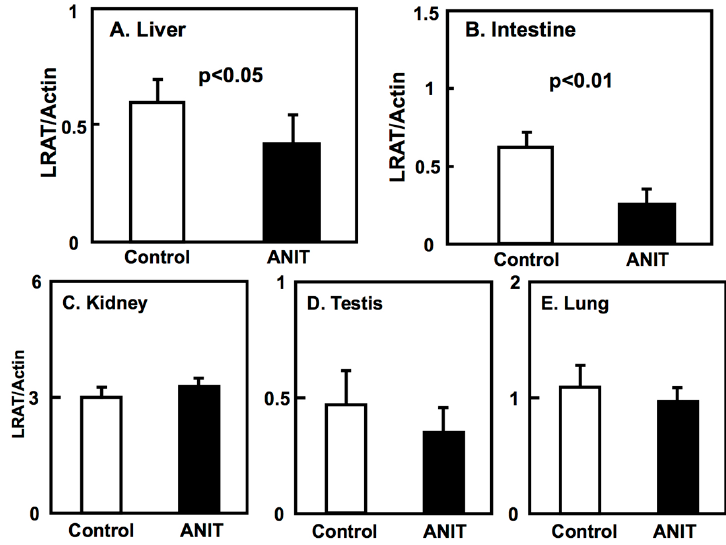
Figure 5. Tissue-specific expression of LRAT in control and ANIT rats. The LRAT mRNA levels of peripheral tissues including liver ( A ), intestine ( B ), kidney ( C ), testis ( D ), and lung ( E ) were examined in treated and control groups ( n = 5 for each group) by quantitative real-time PCR. Each bar represents the mean value ± SD and significant differences are indicated in the graph.